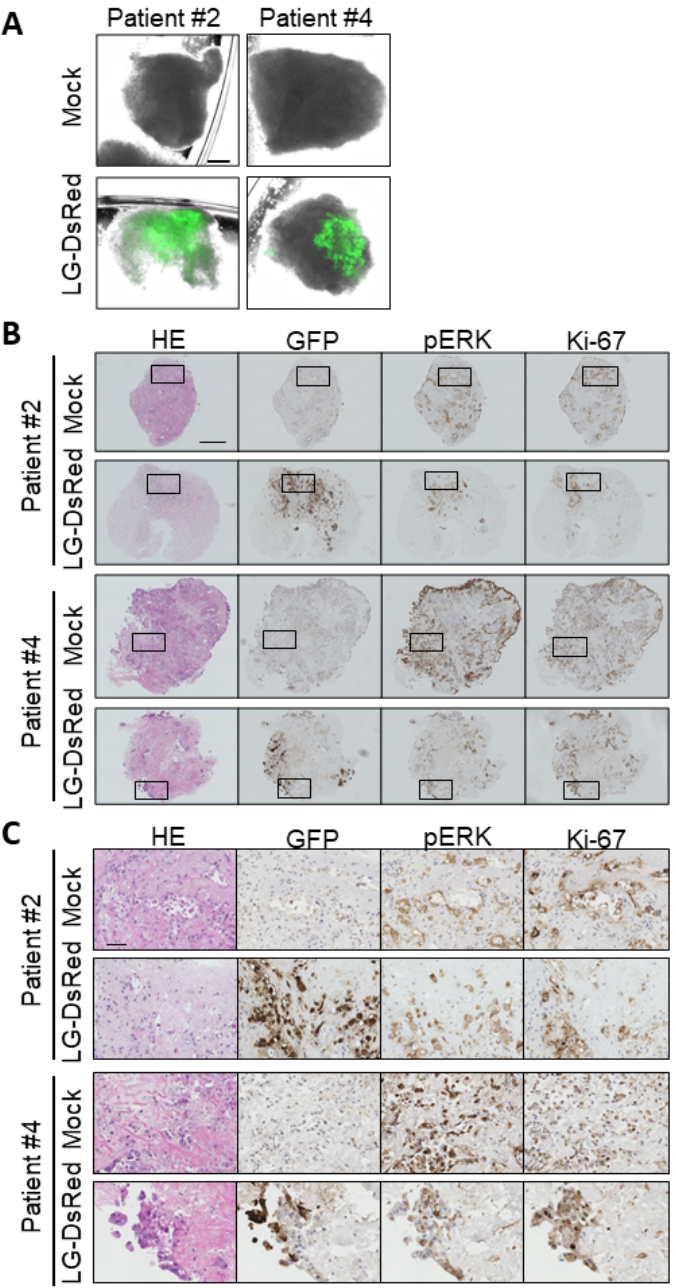
Figure 7. Mitogen-activated protein kinase-dependent recombinant vaccinia virus (MDRVV) achieves tumor-selective replication in tissue cultures from pancreatic ductal adenocarcinoma (PDAC) patients. ( A ) Minced pancreatic tissue samples derived from human pancreatic cancer patients were infected with 1 × 10 6 plaque-forming units (PFU) of LG-DsRed. Viral GFP was photographed at 120 h after infection (scale bar: 300 µ m). ( B ) Immunohistochemical staining of human tissue samples in ( A ). Tissues were stained with hematoxylin and eosin, an anti-GFP antibody, an anti-phosphorylated p44/42 MAPK protein (Erk1/2) antibody, or anti-Ki-67 (scale bar: 300 µ m). ( C ) Extended images of those marked with squares in ( B ) (scale bar: 50 µ